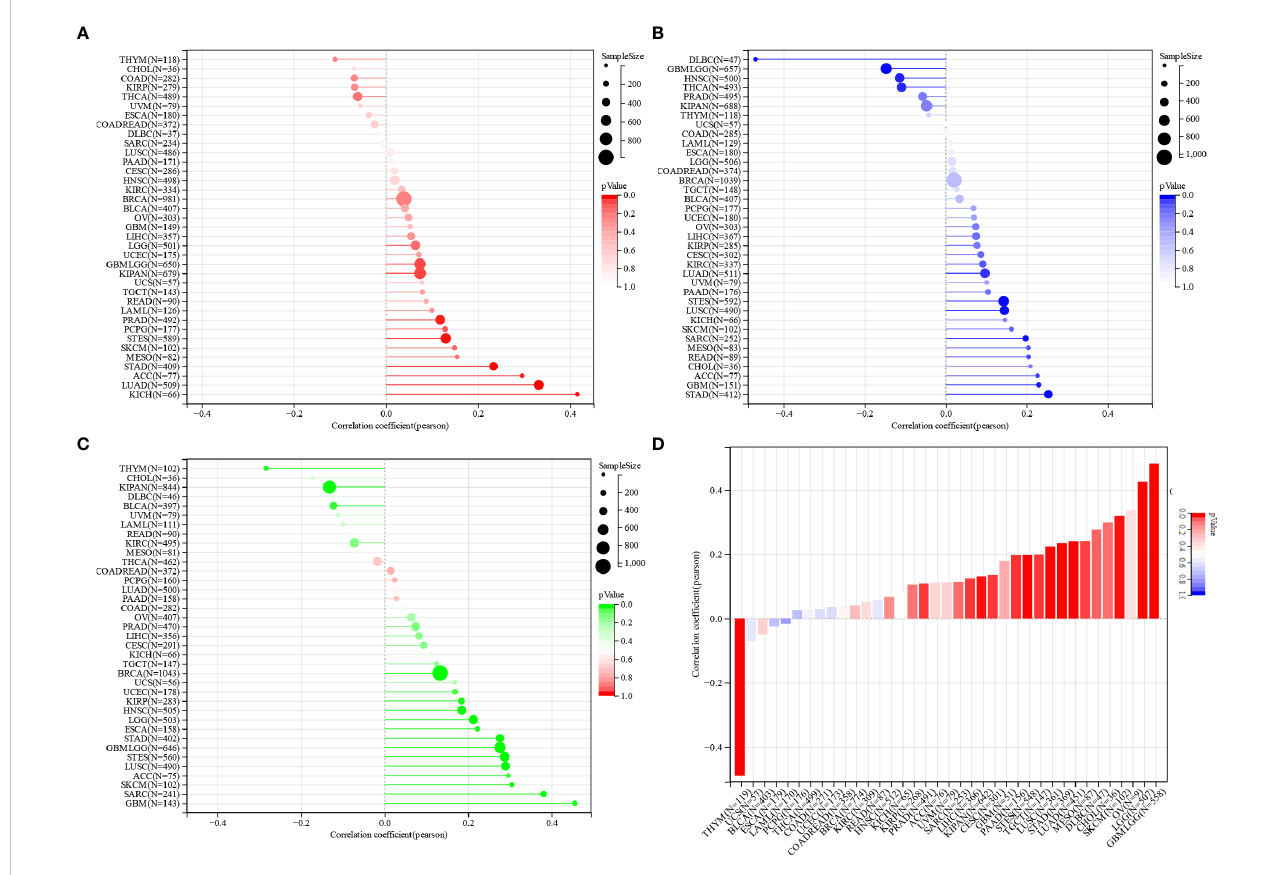
FIGURE 7 Prediction of treatment response to ICIS by NCAPG2 (A) Correlation analysis of the association between NCAPG2 expression and TMB, (B) MSI, (C) tumour purity and (D) stemness